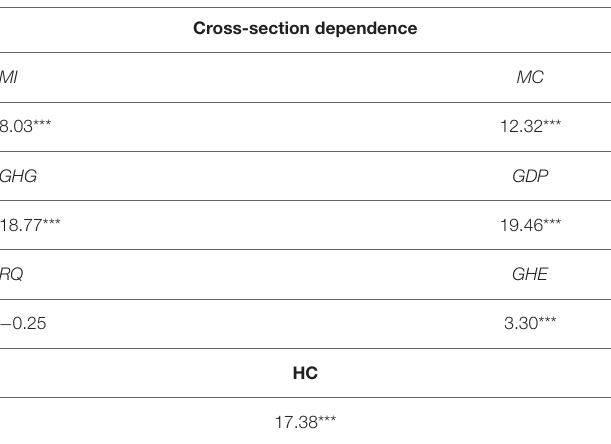
TABLE 3 | Cross-section dependence.